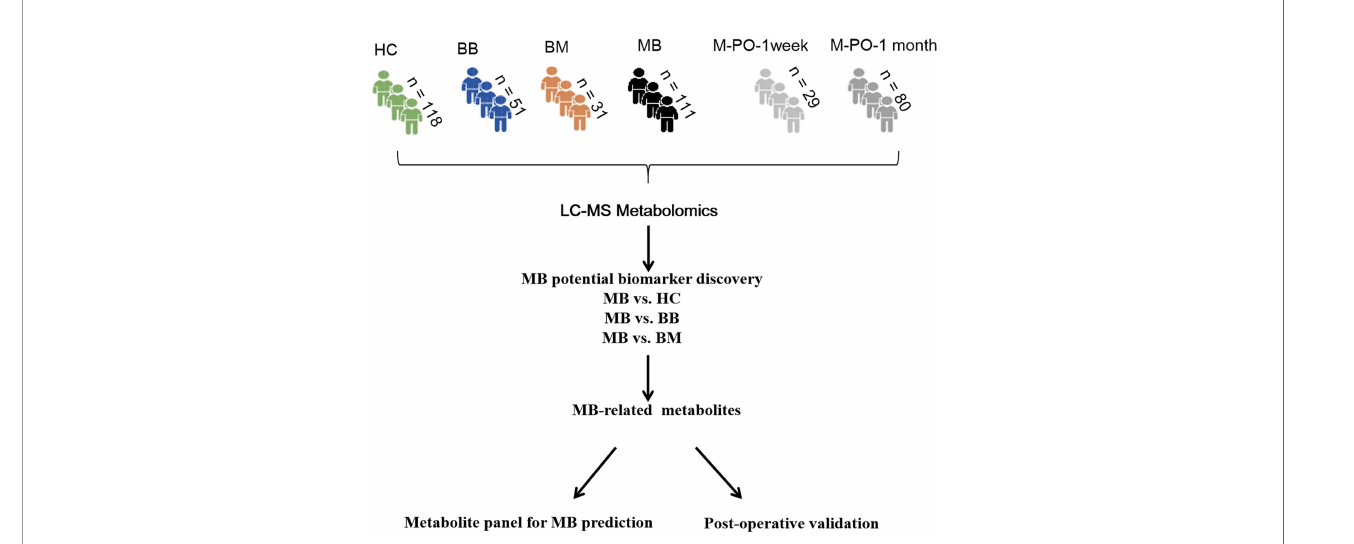
FIGURE 1 | Study work fl ow. HC, healthy control; BB, benign brain disease; BM, other malignant brain tumor; MB, medulloblastoma; M-PO-1 week, medulloblastoma 1 month postoperatively, M-PO-1 month: medulloblastoma 1 month